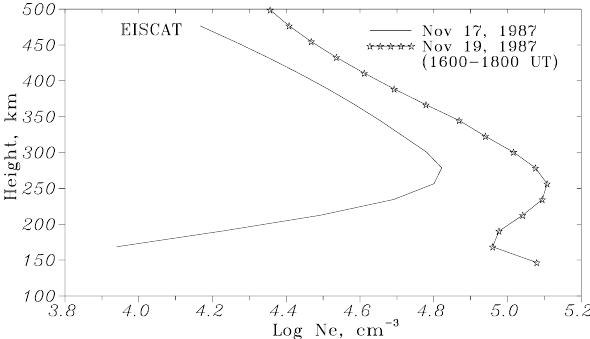
Fig. 5. Observed with EISCAT median N e (h) profiles calculated over two hours. Note the effect of strong particle precipitation in the N e (h) height distribution on 19